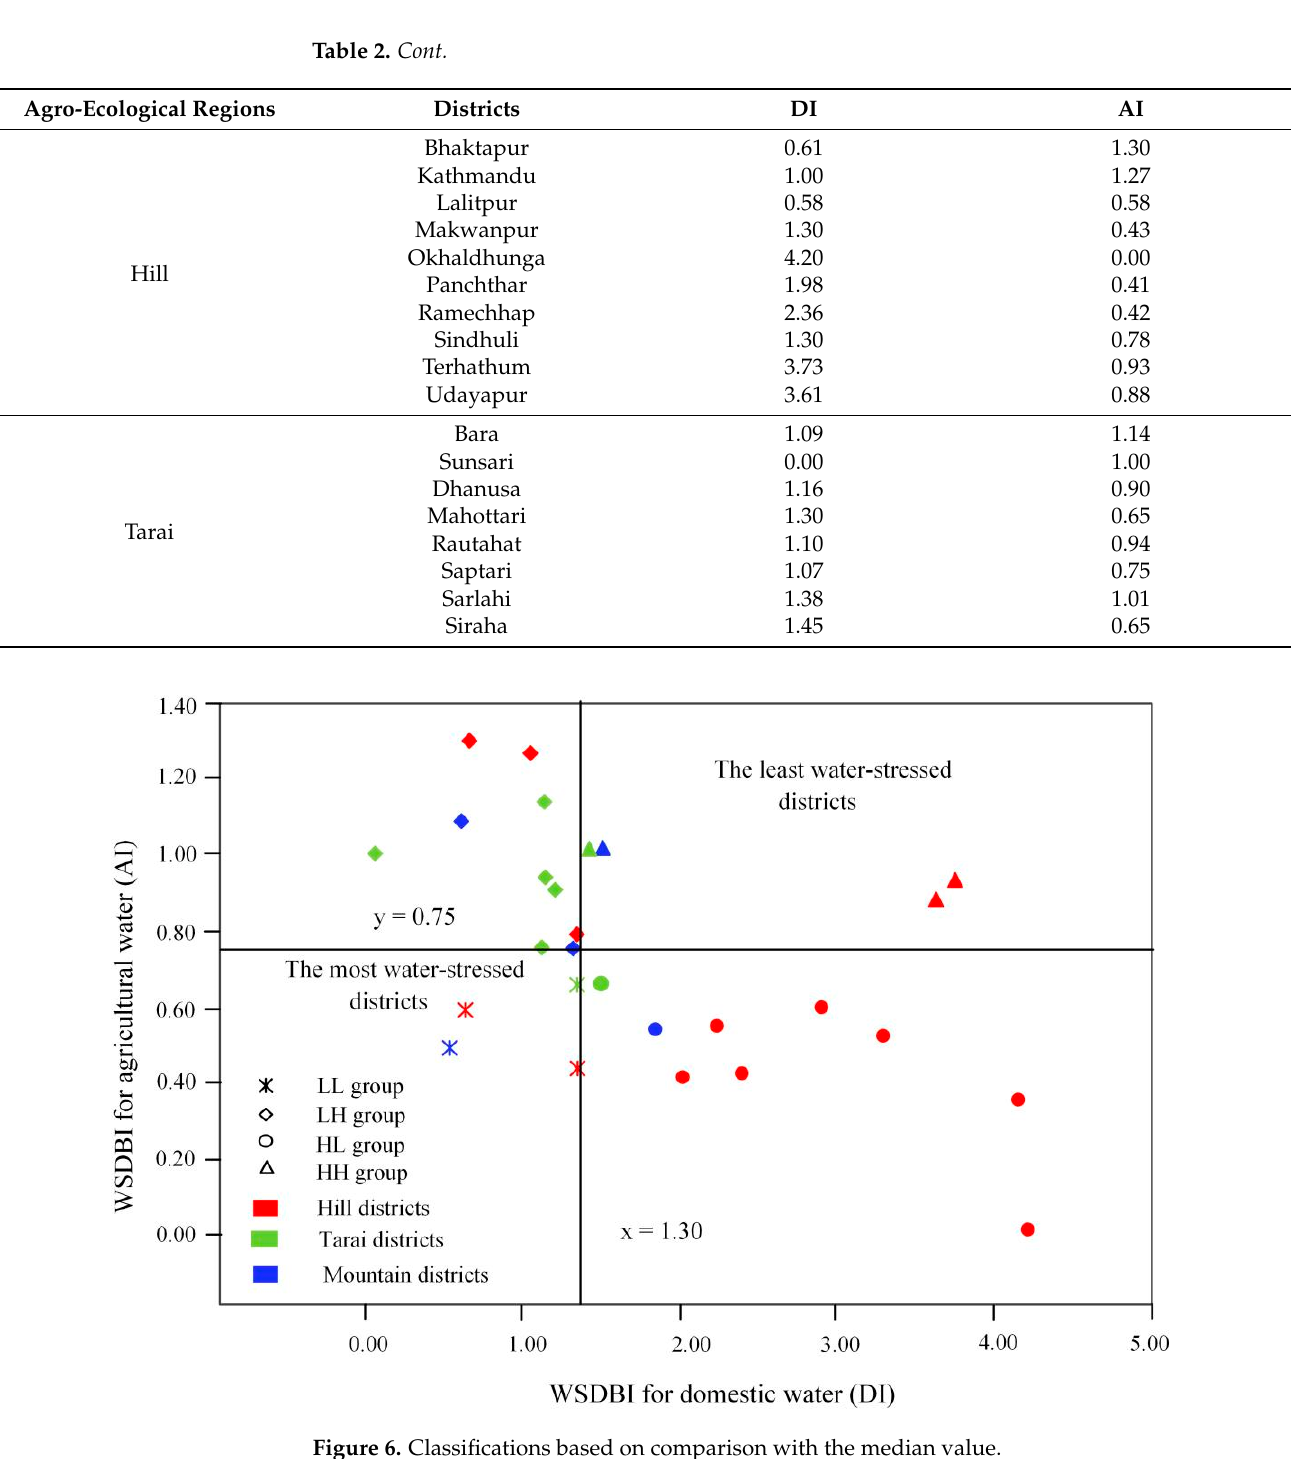
Figure 6. Classifications based on comparison with the median value.